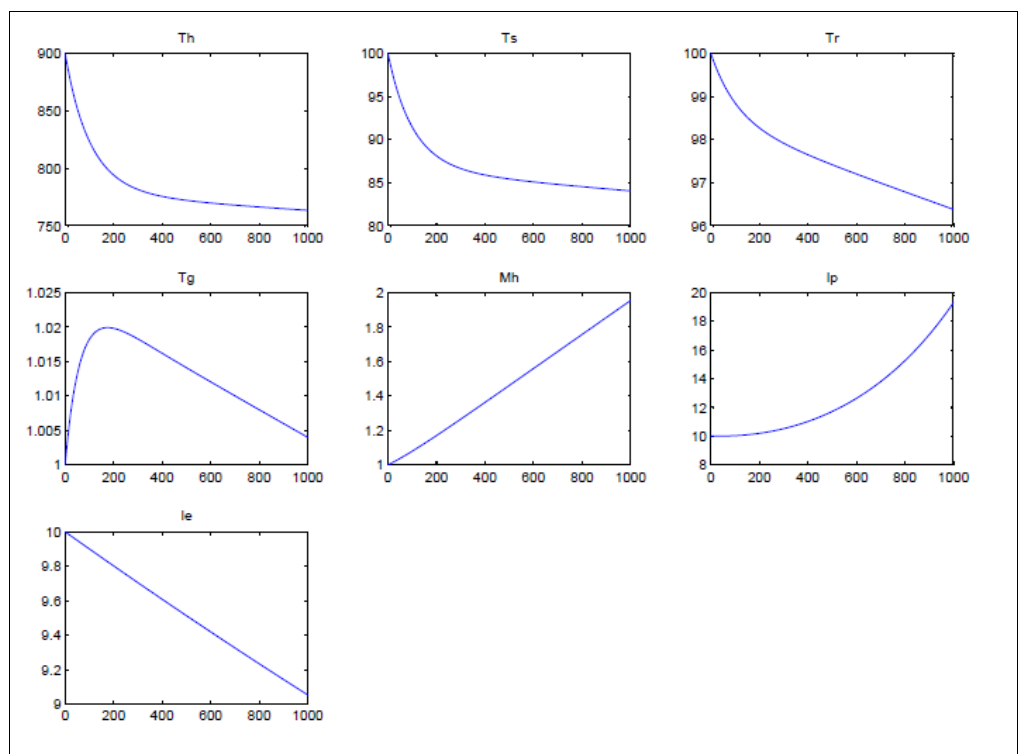
Figure 2. Lymphocytes, macrophage, and CTL dynamics (concave